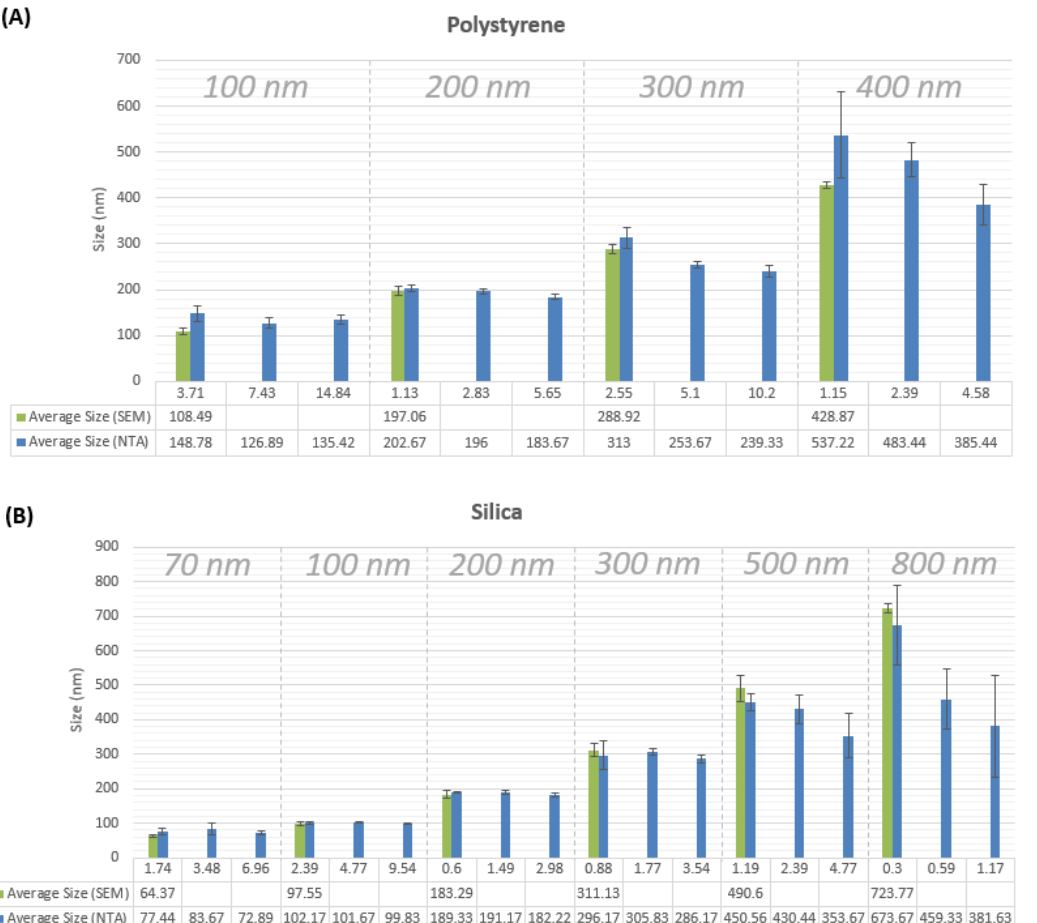
Figure 1. Particle size measurements by SEM and NTA of three different concentrations. The calculated values of prepared concentrations × 10 8 particle/mL for each nominal particle size are shown on the x -axis. Each sample of nanoparticles is measured by NTA in triplicate by three different researchers on three separate experiments, leading to nine measurements for each sample. For SEM particle sizes, measurements were taken from images of twenty five particles for each nominal particle size. ( A ) refers to polystyrene nanoparticles, ( B ) refers to silica